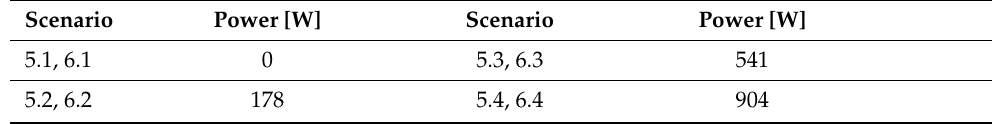
Table 4. Load power settings for DC Scenarios 5 and 6.